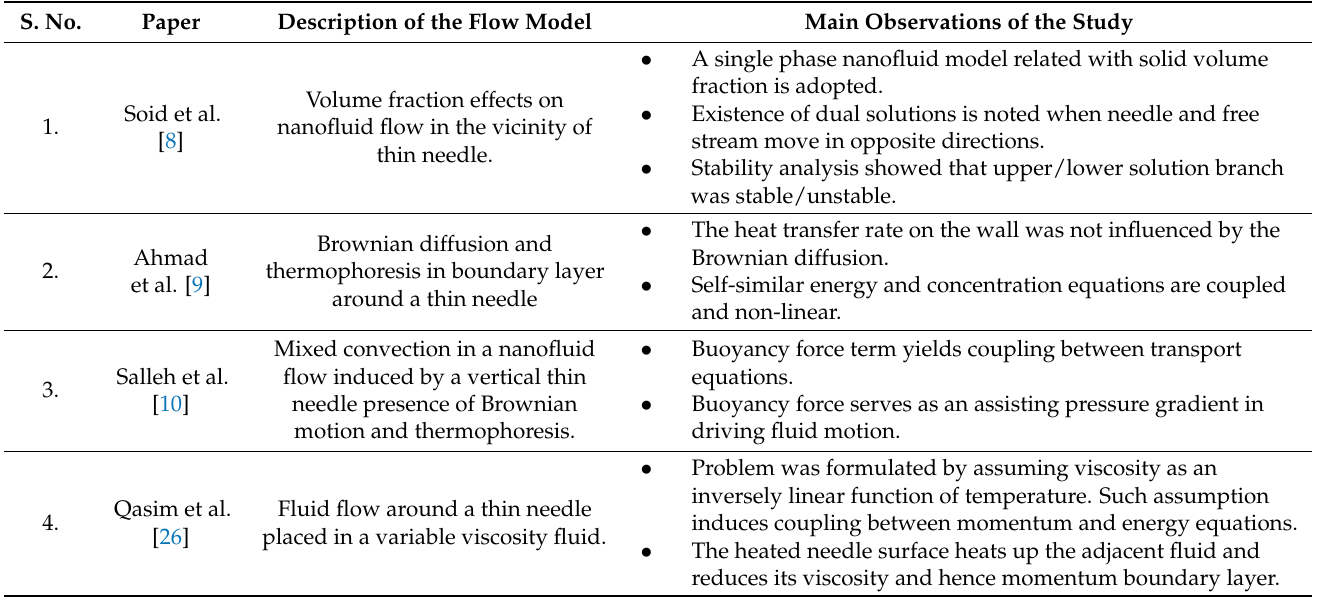
Table 1. A summary of previously published research on boundary layer formation around thin needle (slender)